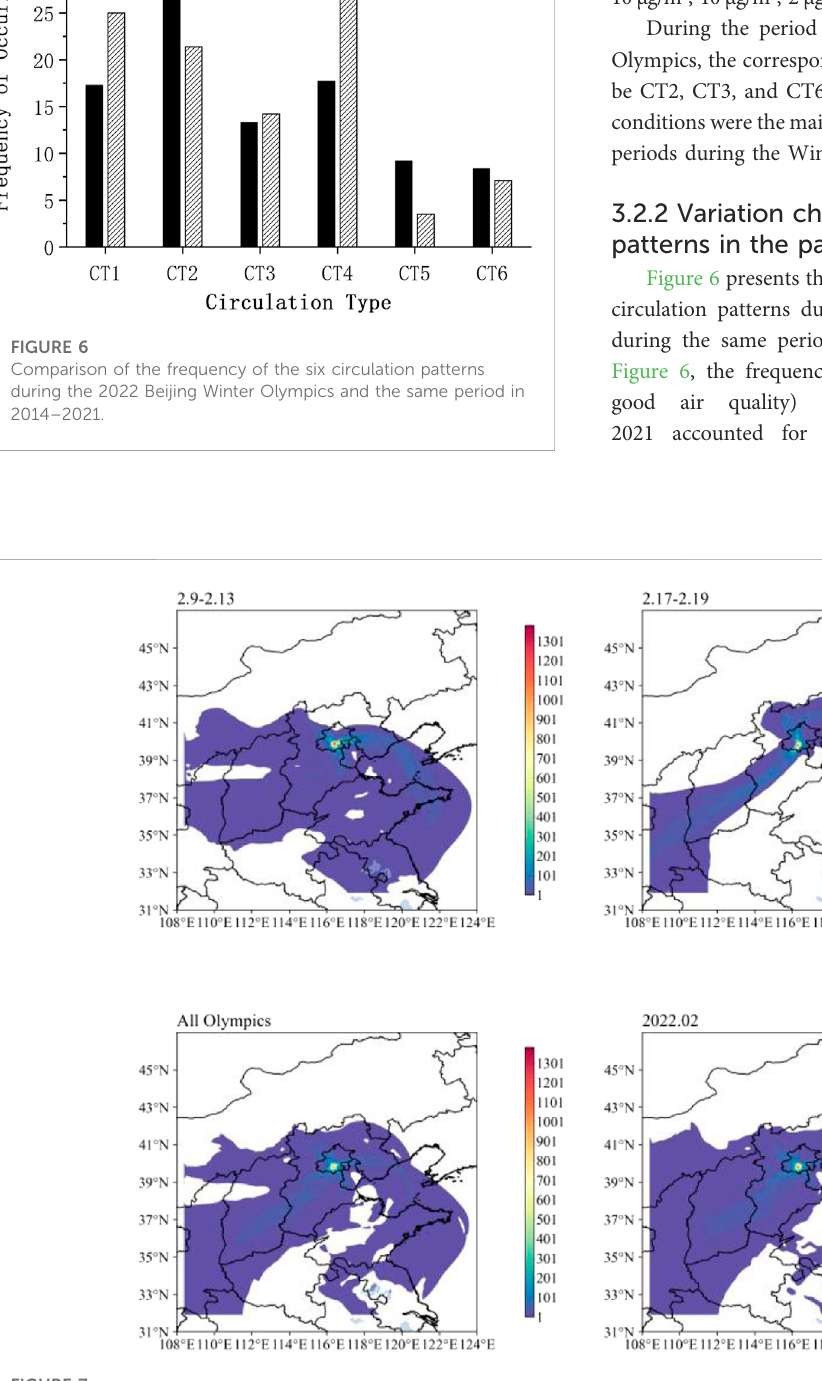
Frontiers in Environmental